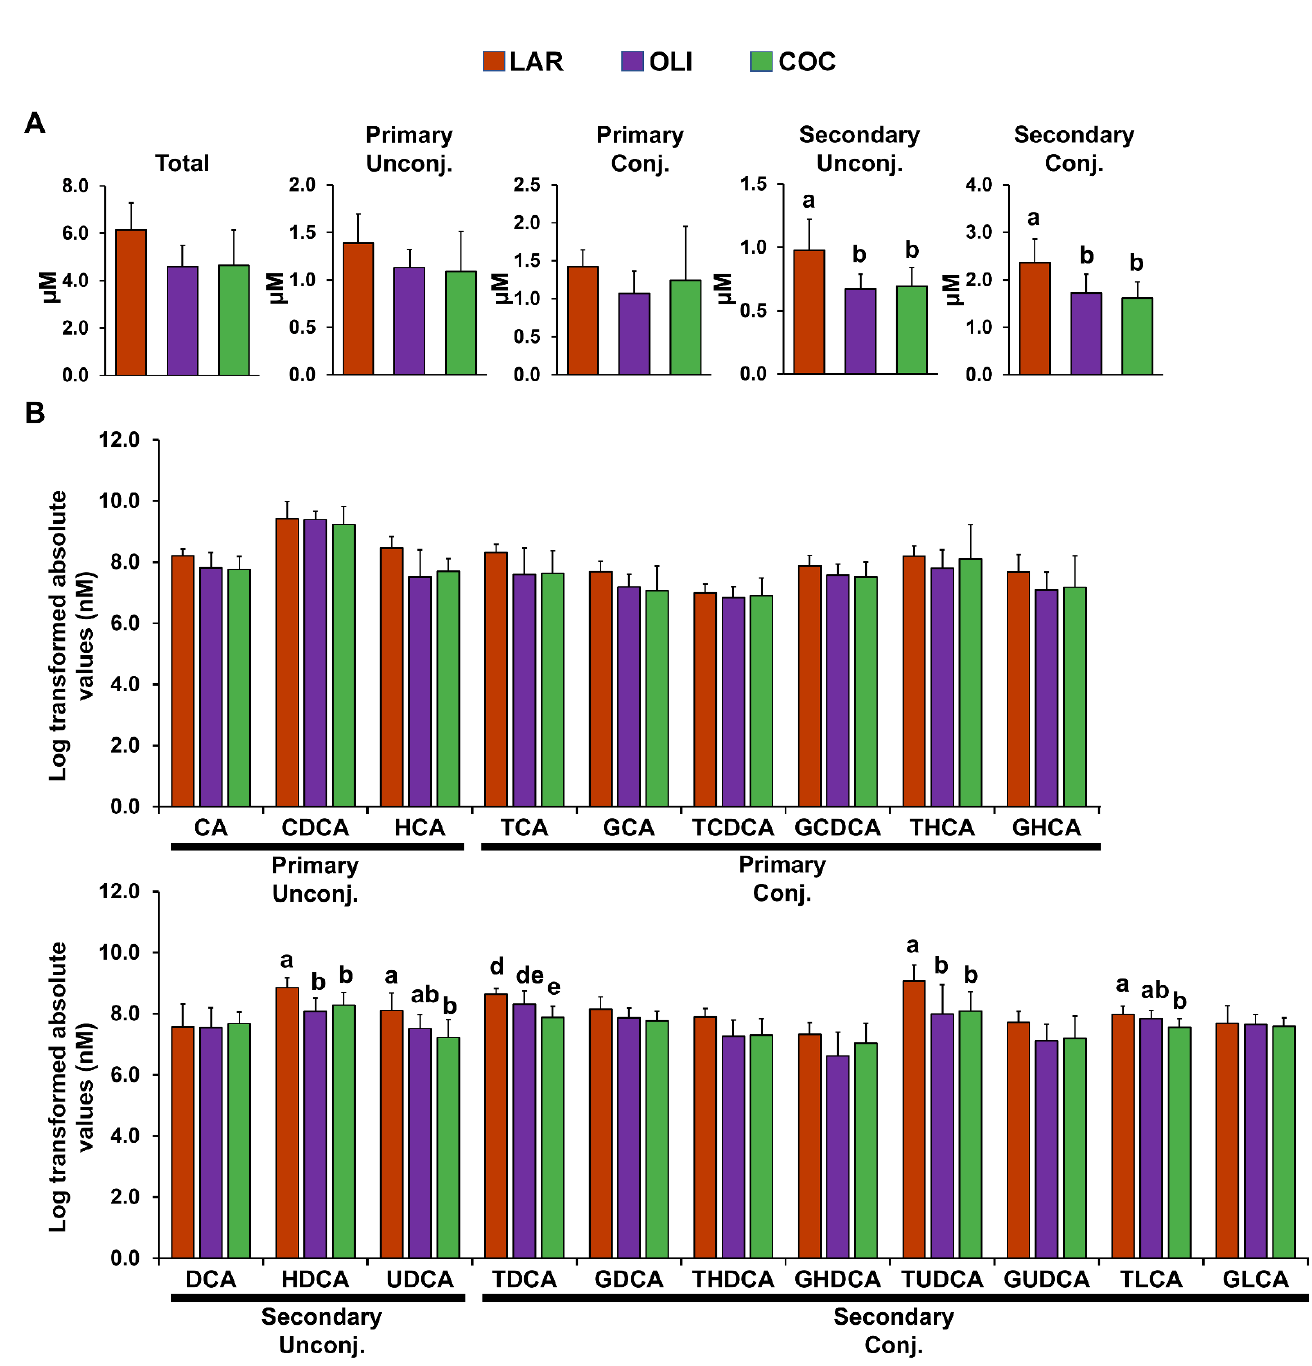
Figure 4. ( A ) Total, primary, and secondary levels of BAs in the frontal cortex of juvenile Iberian pigs fed LAR ( n = 5 pens), OLI ( n = 5 pens), and COC ( n = 5 pens) diets on day 70 of the study. ( B ) Abundance of individual BAs in the frontal cortex. p -values for each metabolite were calculated by one-way ANOVA and a mixed model that included diet as fixed effect, and both replicate and pen nested in diet as random effects, and further adjusted for multiple testing with the Benjamini– Hochberg procedure. Values are means ± SDs. p -values were adjusted for multiple testing with Tukey’s post hoc test. ab p ≤ 0.05, de p ≤ 0.01. CA, cholic acid; CDCA, chenodeoxycholic acid; COC, coconut oil diet; DCA, deoxycholic acid; G, glycine conjugated; HCA; hyocholic acid; HDCA, hyodeoxycholic acid; LAR, lard diet; LCA, lithocholic acid; OLI, olive oil diet; T, taurine conjugated; UDCA, ursodeoxycholic acid.